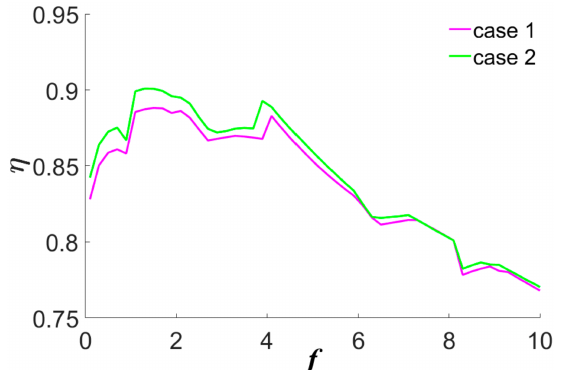
Figure 20. Comparison of two layout cases under different excitation